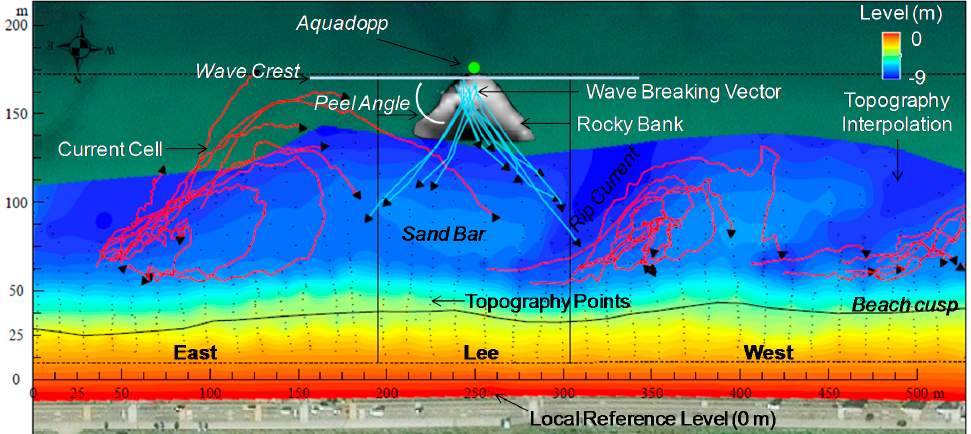
Figure 2. Map of surveyed data at Reserva Beach with: the presence of a rocky bank in the system; topographic points cloud used for the bathymetry; the zones of the morphological feature monitoring (east, lee, and west) as well as the position of the Aquadopp. Additionally, the figure shows examples of wave characteristics on the rocky bank (crest and peel angle) and the main morphological (the beach cusp and the sand bar at the lee of the submerged structure) and hydrodynamics features (currents cell tracked with red lines and wave breaking vector tracked with light blue